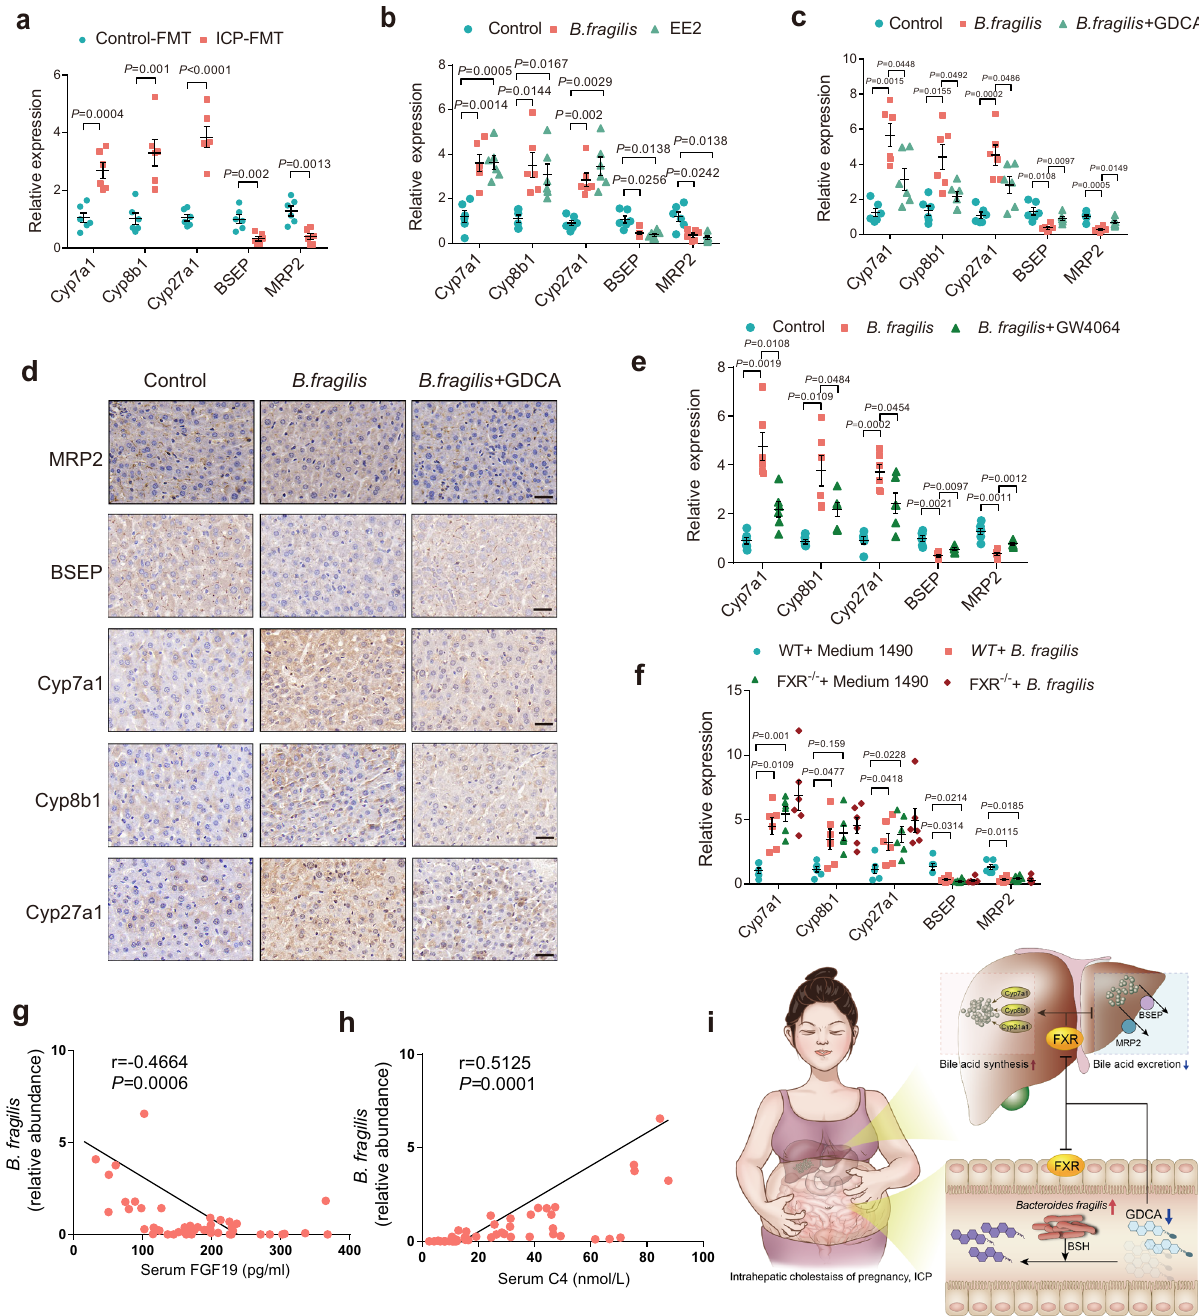
Fig. 6 | B. fragilis inducesexcessive bileacid synthesis and inhibits hepatic bile acidexcretionthroughsuppressionofFXRsignalingtopromoteICP.a Hepatic mRNA expression levels of bile acids synthetic and bile excretory genes in mice transplanted with fecal microbiota of ICP and healthy controls ( n =6 per group). P values were determined by two-tailed Student ’ s t-test. b Hepatic mRNA expres- sion levels of bile acids synthetic and bile excretory genes in control group, B. fragilis groupandEE2group( n =6pergroup). c HepaticmRNAexpressionlevelsof bile acids synthetic and bile excretory genes in each group ( n =6 per group). P values were determined by Welch ANOVA with Games-Howell ’ s multiple compar- isons test for b , c . d IHC staining of hepatic bile acids synthetic and bile excretory